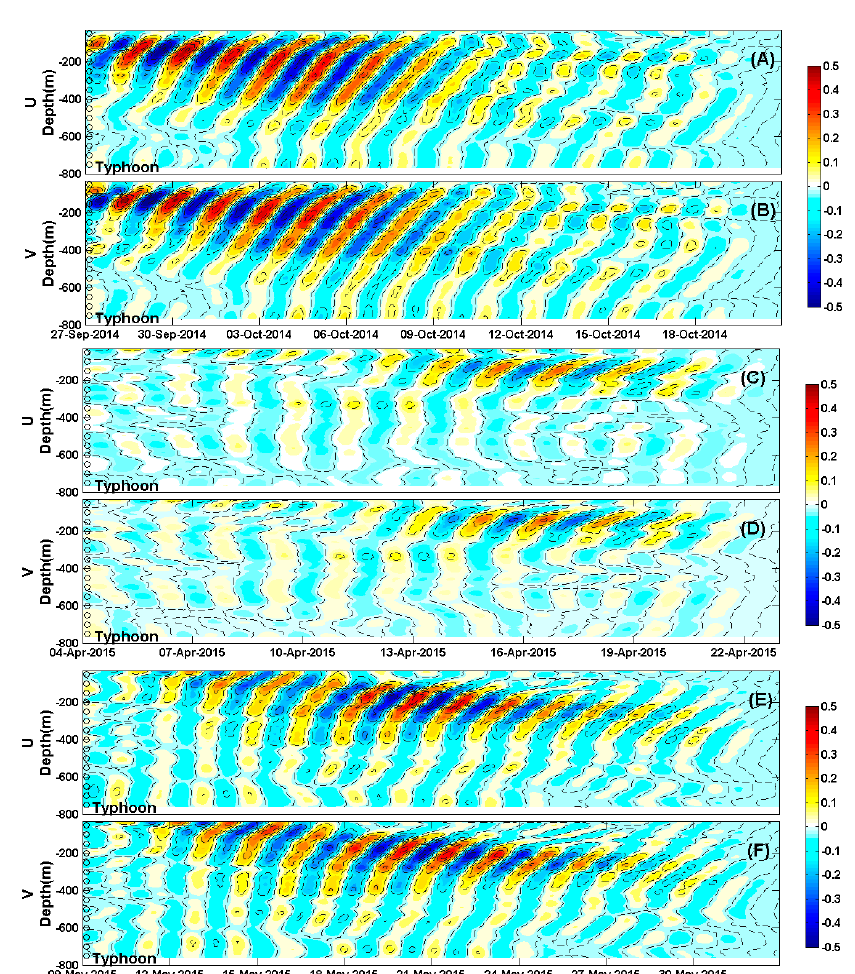
Figure 4. Time evolution of the cross-track component of the band-pass filtered ( σ ∈ [0.7, 1.2] f ) ( A , C , E ) eastward and ( B , D , F ) northward ocean currents (m s -1 ) at 40–800 m deep. The first near inertial current is shown in ( A , B ). The second is shown in ( C , D ). The third is shown in ( E , F ). The horizontal axis of the figure is time. The vertical axis is the water depth with the unit m. The black circles indicate the times the typhoons were closest to the mooring. Note that the different color-bars are for the three typhoon events.